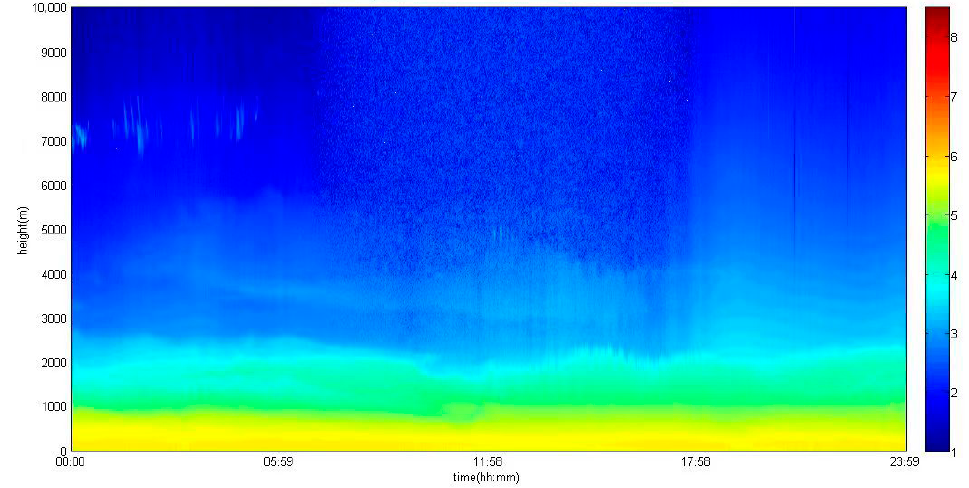
Figure 6. Pseudo color map for aerosol extinction coefficient (10 − 4 m − 1 ) in Hefei on 11 February 2021.